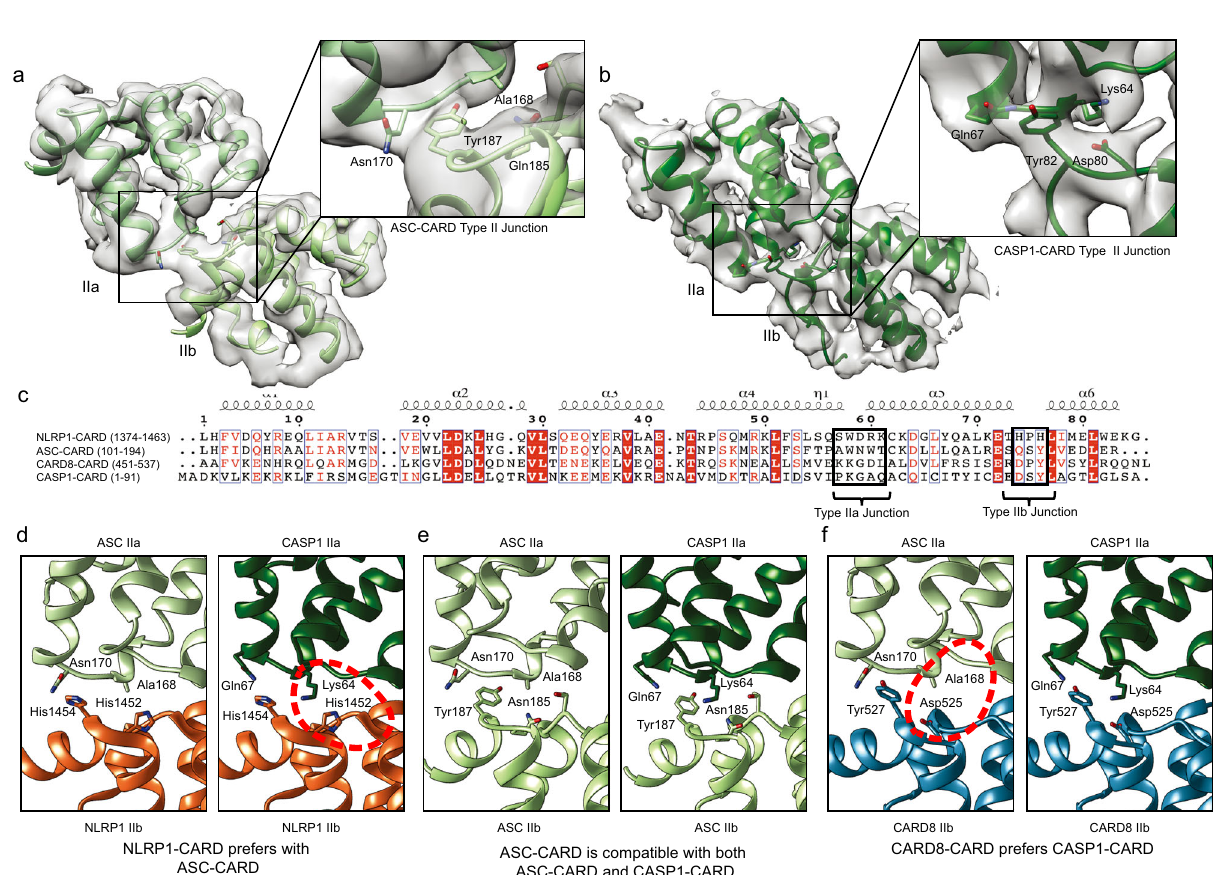
Fig. 5 Type IIa – b interface in fl uences human in fl ammasome complexes. a Type II interface in ASC-CARD fi laments (PDB-6K99, EMD-9947). b Type II interface in CASP1-CARD fi laments after re fi tting. See Fig. S5c for a comparison between the re fi tted model and the original model, PDB-5FNA, and EMD- 3241). c Sequence alignment of human NLRP1-, ASC-, CARD8-, and CASP1-CARD. Important residues within the Type II interfaces are highlighted in black box. d Structural compatibility of human NLRP1-CARD with ASC-CARD or CASP1-CARD. Potential clashes are highlighted in red. e Structural compatibility of human ASC-CARD with itself or CASP1-CARD. f Structural compatibility of human CARD8-CARD with ASC-CARD or CASP1-CARD. Potential clashes are highlighted in NLRC4-CARD, we determined its fi lament structure at 3.3 Å using cryo-EM (Supplementary Fig. 6d, e). The fi nal polished structure closely agrees with previously published fi ndings 24,39 . strong density bridge in the Type II interface is absent within NLRC4-CARD fi laments (Supplementary Fig. 10a). The Type IIb ASC-GFP and CASP1 C285G-GFP specks, as well as ASC- tyrosine residue (Tyr78) is folded backward toward the hydro- phobic core and does not participate in intermolecular Type II (Supplementary Fig. 10c, d). The versatility of human NLRC4- interaction. Instead, two nearby small residues, Asn77 and Gln82, CARD is in agreement with previous studies on murine Nlrc4. In come forward to form a class of Type II junction (Supplementary mice, Asc/Pycard knockout attenuates, but does not abolish Fig. 10a, b) that is more fl exible than that of NLRP1 and CARD8. caspase-1-dependent pyroptotic cell death 41 , suggesting that